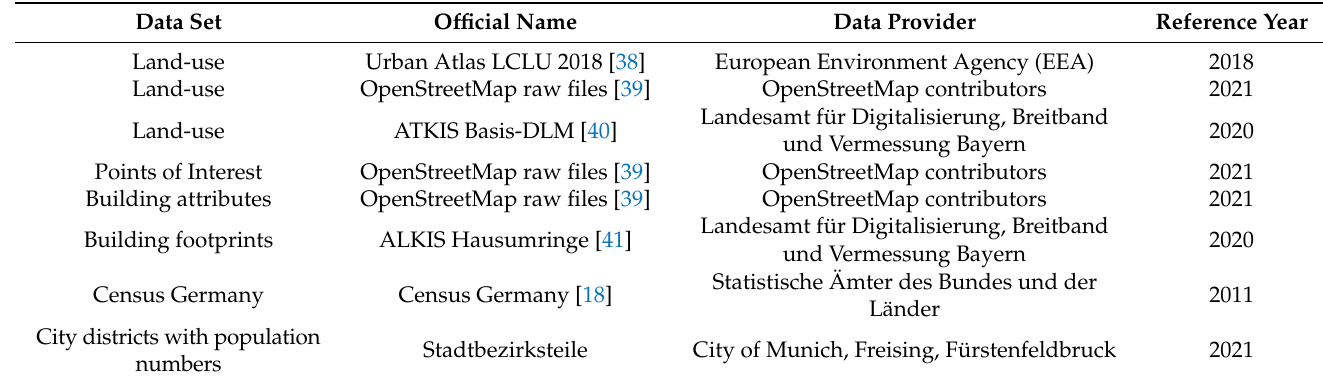
Table 1. Data used for population